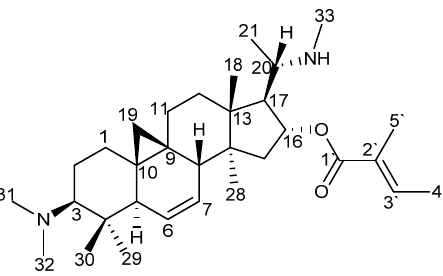
Figure 4. Chemical structure of O -tigloylcyclovirobuxeine-B ( 1 ).